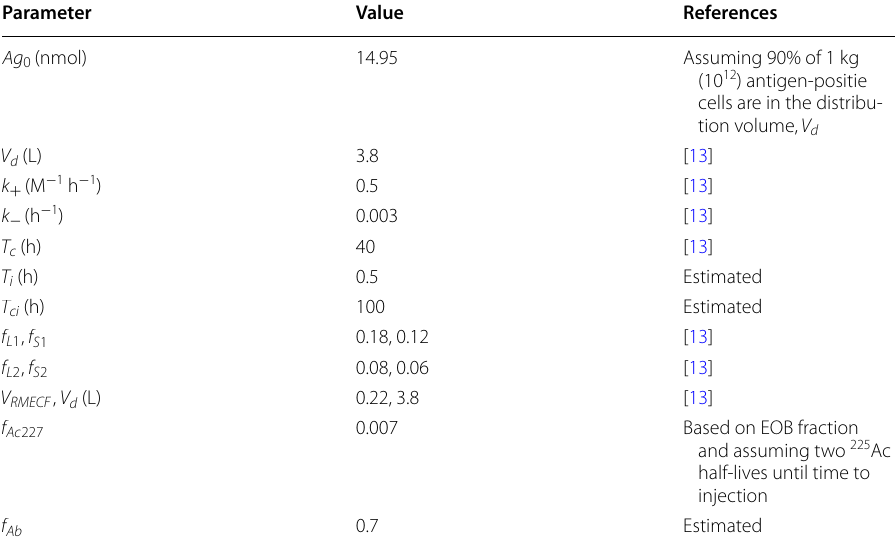
Table 2 Model parameter